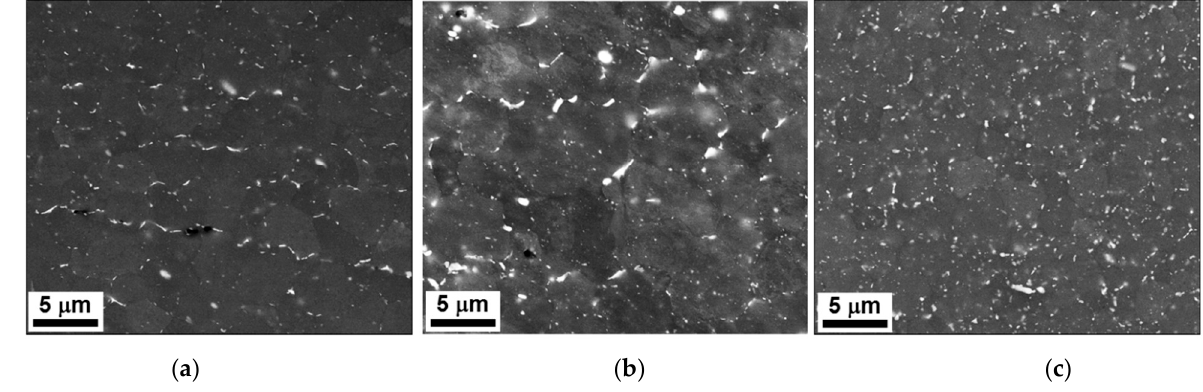
Figure 5. Typical backscatter-electron-scanning electron microscopy (BSE-SEM) images taken from different locations of high-heat-input weld: ( a ) upper surface, ( b ) weld nugget, and ( c ) weld root. Note: Secondary precipitates appear bright.